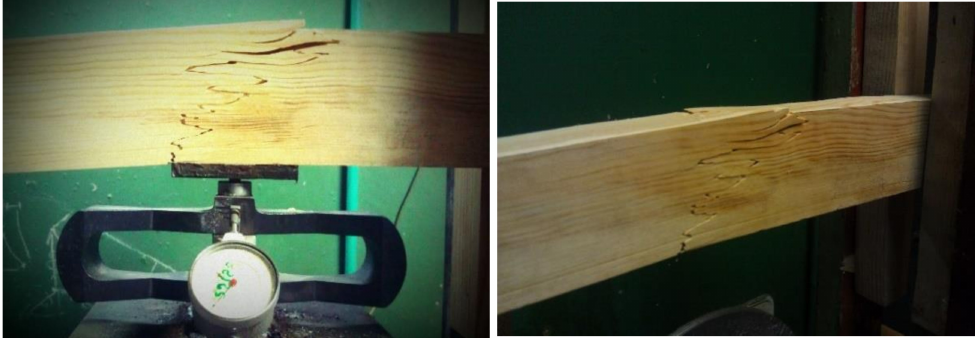
Figure 7. Characteristic fracture of reinforced beams during their failure.